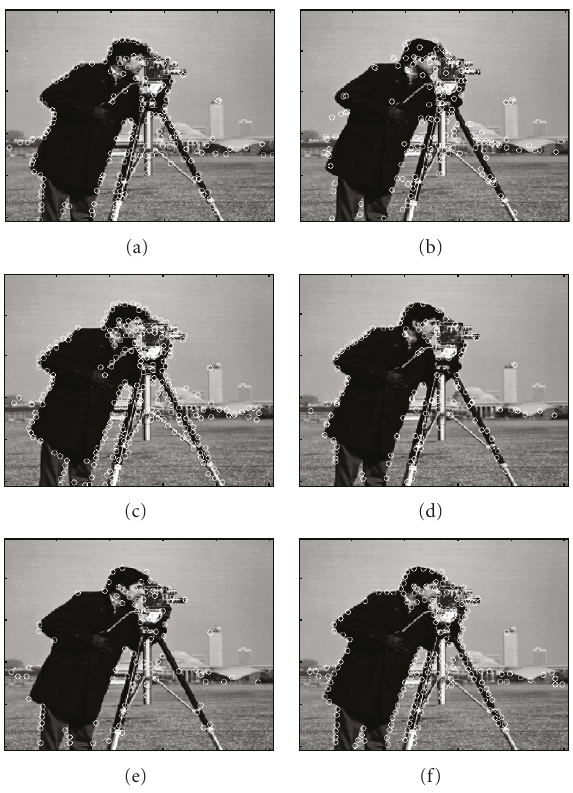
Figure 14: Feature points detected in the second image by (a) Harris method (b) Lowe’s method, (c) Tomasi’s method, (d) Loupias’s technique, (e) Yeh’s algorithm, and (f) proposed technique.